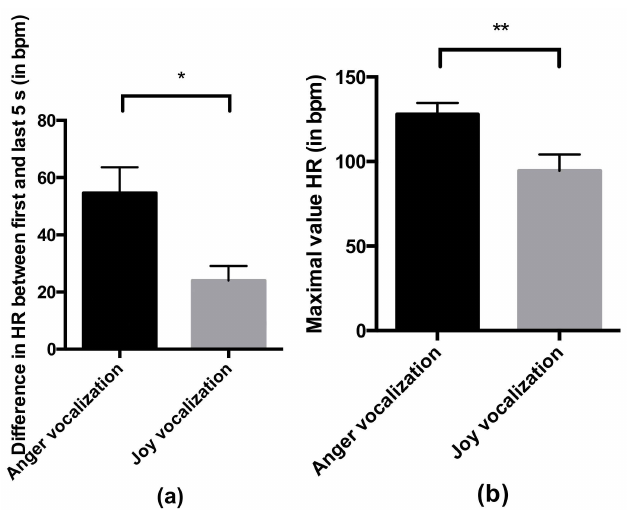
Figure 4. E ff ect of the emotional valence of the vocalization (joy or anger) on the heart rate of the horse during the first trial: ( a ) Di ff erence in the mean heart rate between the first and last 5 s of the trial; ( b ) Maximal value of heart rate during the trial. Significance was assessed by a linear mixed model: * p ≤ 0.05, ** p <